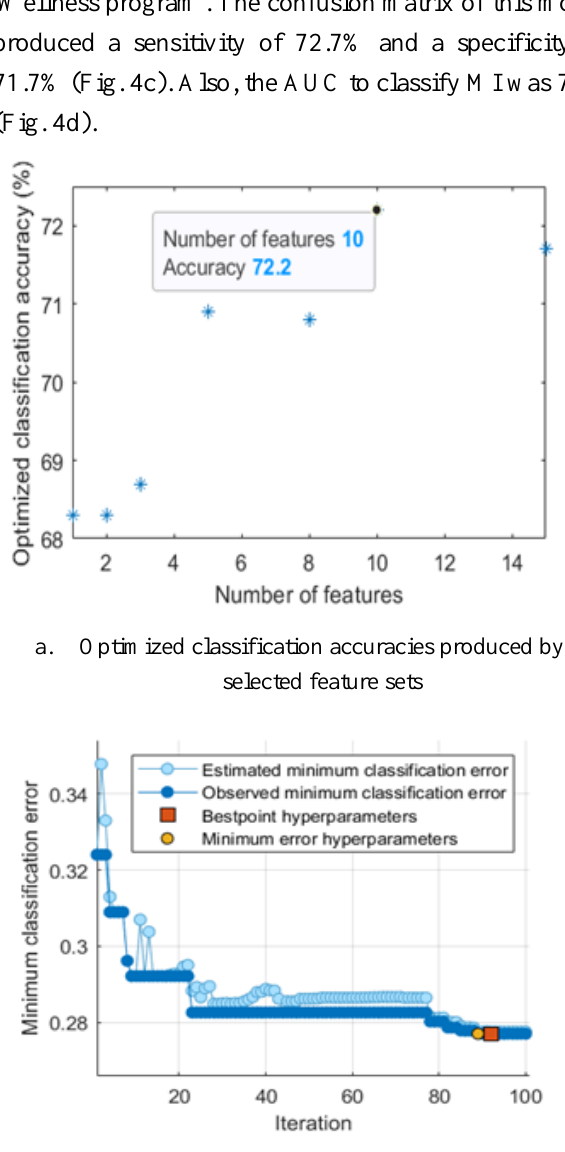
Fig. 3. SVM classification of MI based on treatment. The highest average classification accuracy of 68% with a sensitivity of 80% was produced by the feature ‘Family history’ in 10-fold